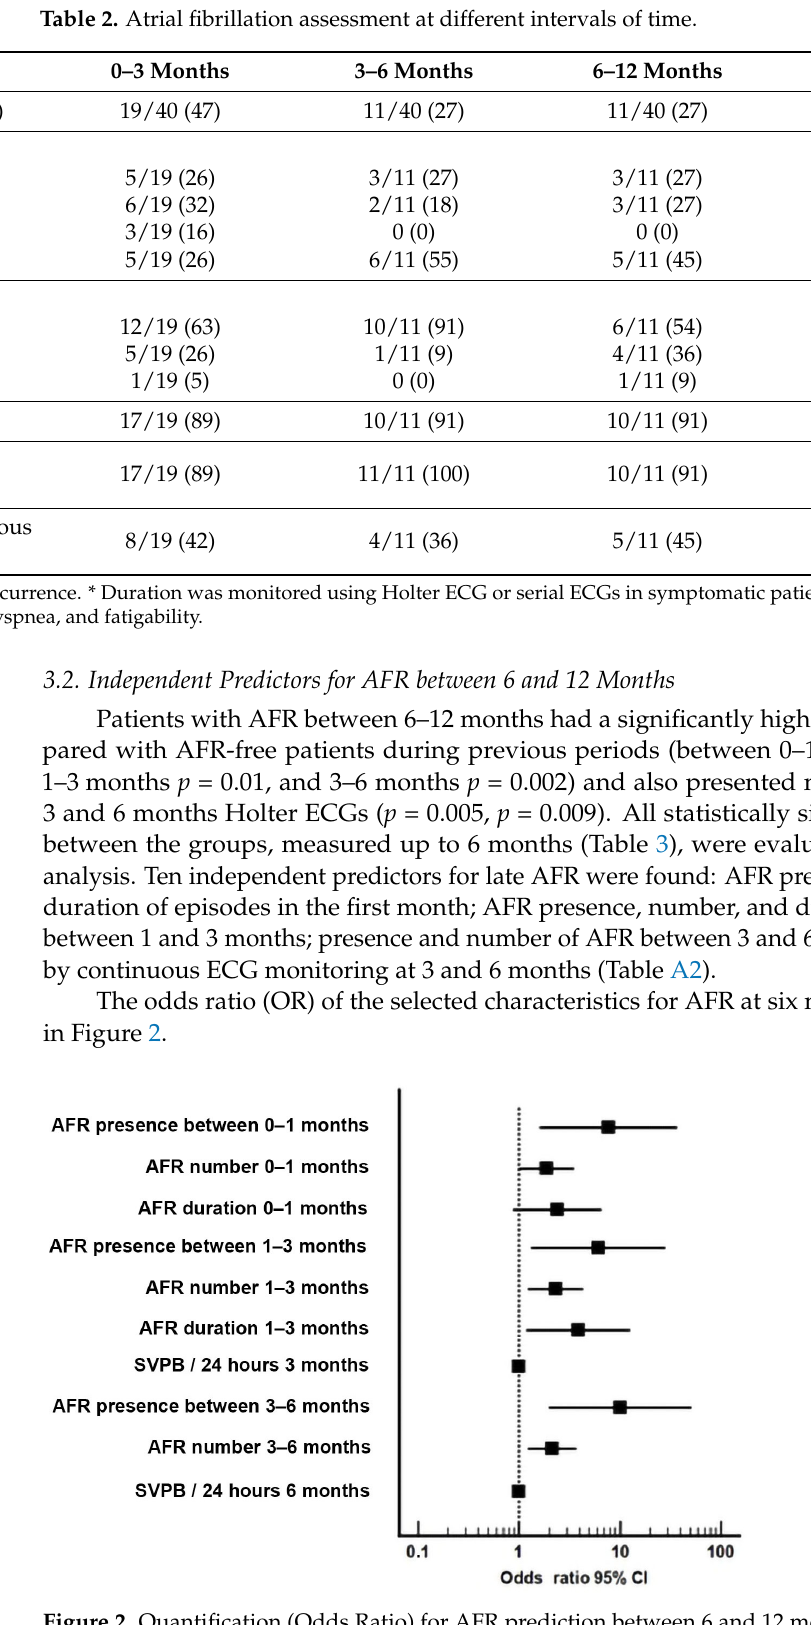
Figure 2. Quantification (Odds Ratio) for AFR prediction between 6 and 12 months after RFCA.